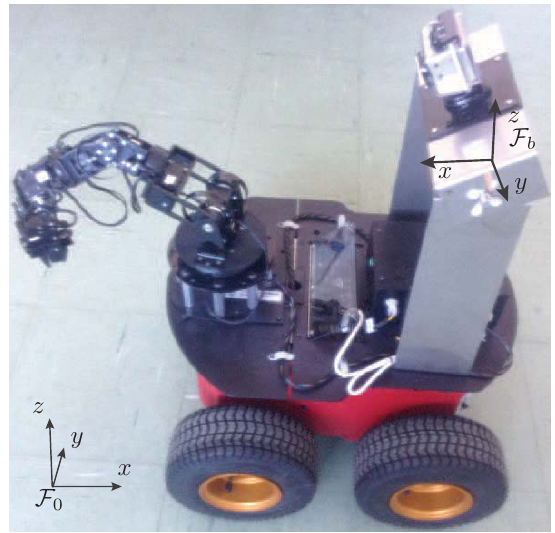
Figure 1: The coordinates of a mobile manipulator with on-board camera